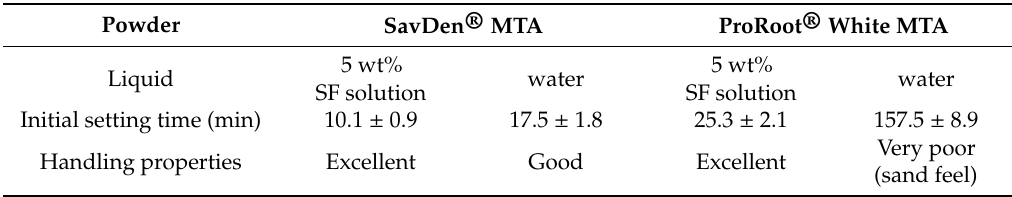
Table 1. Means of initial setting time as well as handling properties of different cement powder-liquid system.